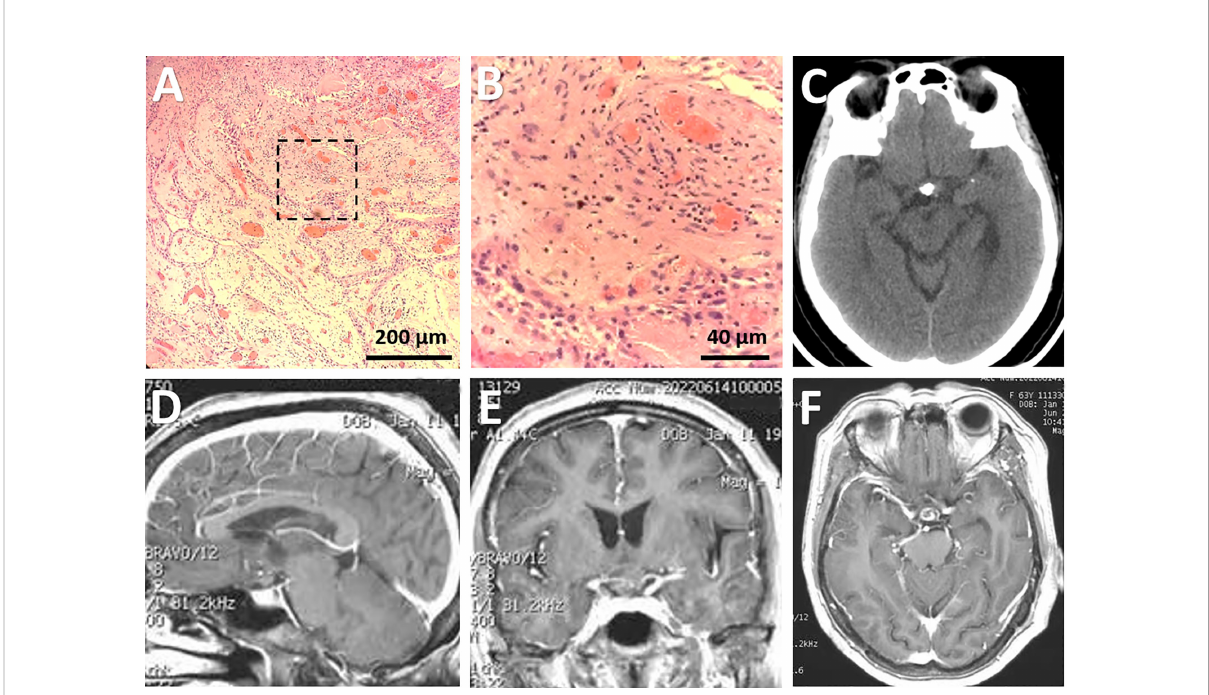
FIGURE 4 Pathological and radiological evaluation of the lesion postoperatively. (A, B) Photomicrographs of hematoxylin-eosin staining showing typical features of papillary craniopharyngioma. The framed area in (A) was magni fi ed in (B) . Bars = 200 m m in (A) and 40 m m in (B) . (C-F) Postoperative CT (C) performed immediately after surgery and post-contrast sagittal (D) , coronal (E) , and axial (F) MRI scans performed three months after surgery showing subtotal removal of the lesion, with a few calci fi ed components left in the suprasellar